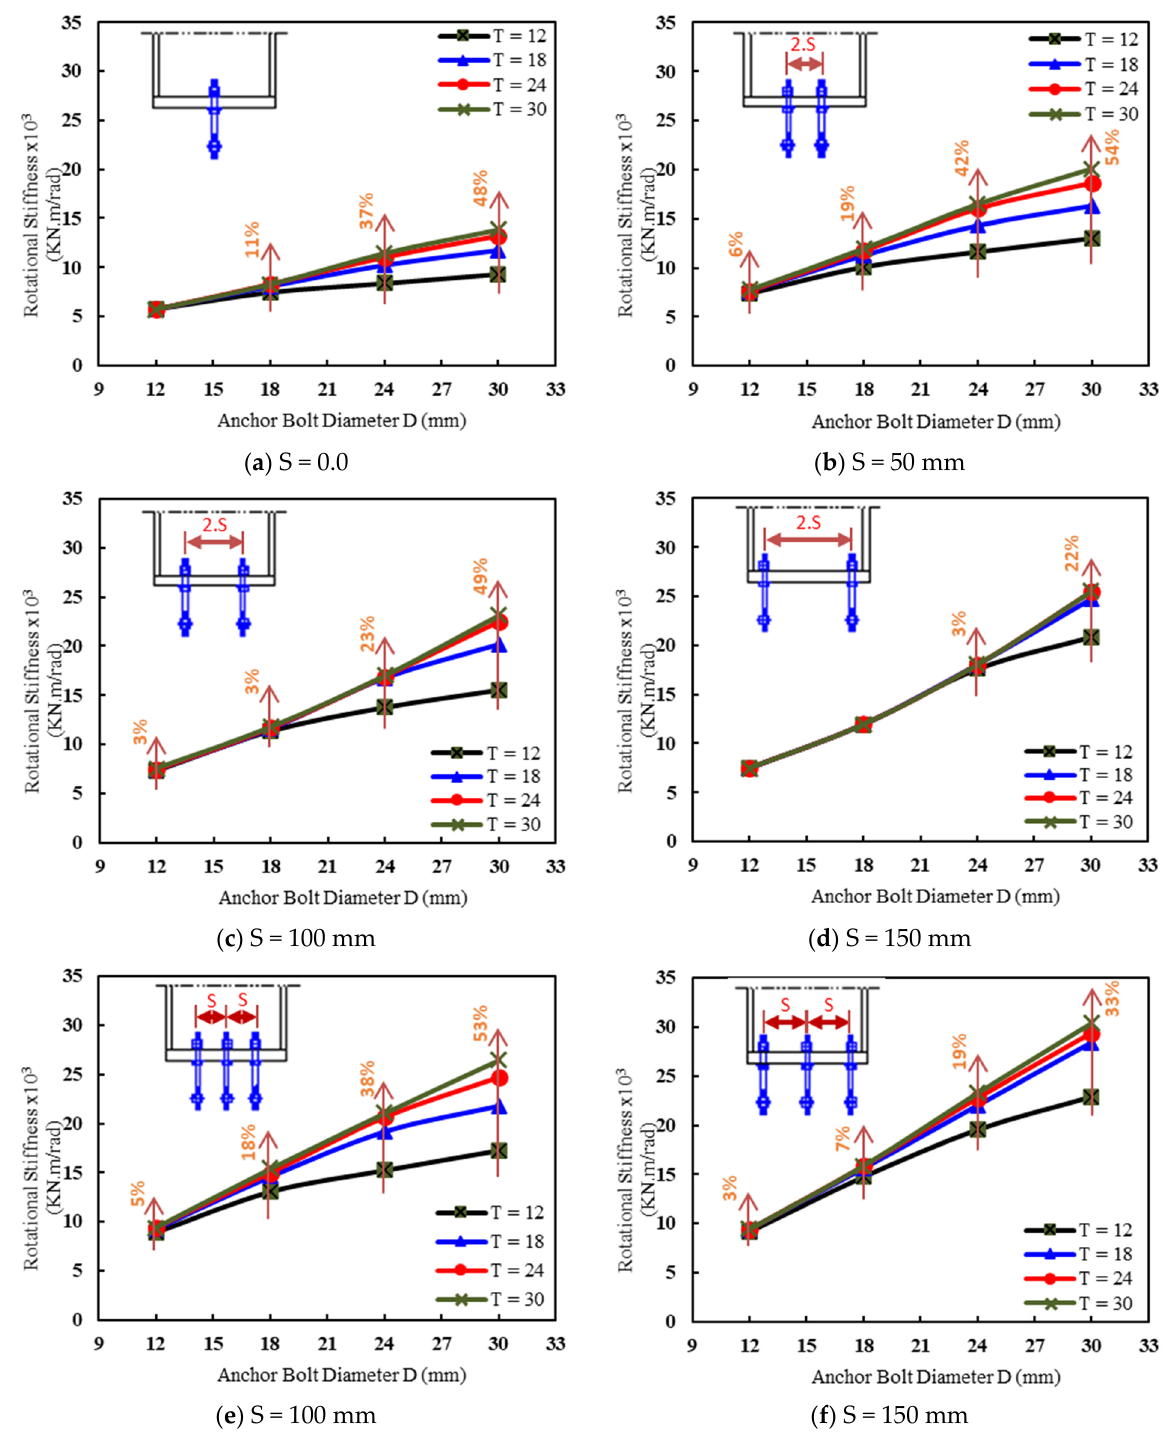
Figure 21. The rotational stiffness vs. the anchor bolt diameter (d) for different base plate thicknesses and arrangements: ( a ) two bolts—S = 0, ( b ) four bolts—S = 50, ( c ) four bolts—S = 100, ( d ) four bolts—S = 150, ( e ) six bolts—S = 100, and ( f ) six bolts—S = 150.